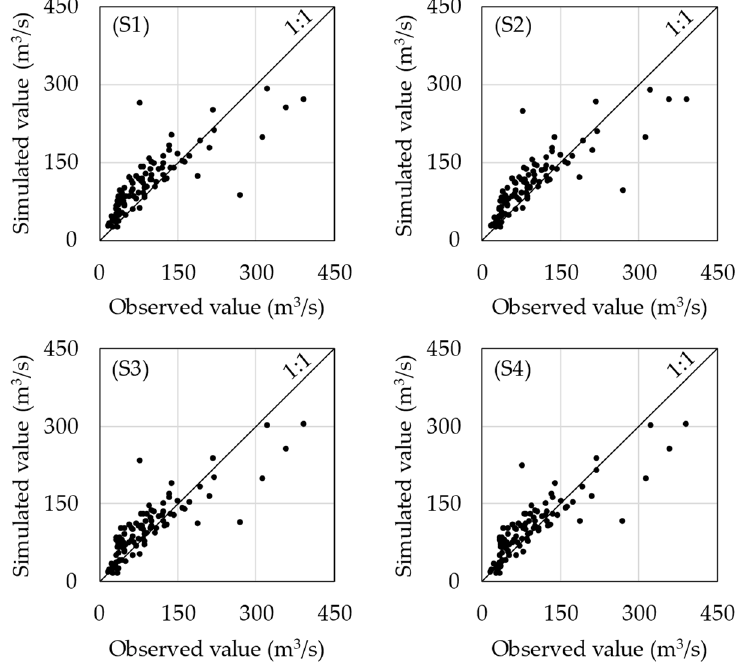
Figure 5. The correlation between the observed and simulated flow discharges in the validation period. S1 represents the simulation results when using the 2005 land- use map for the entire validation period. S2 represents the simulation results when using the 2010 land- use condition for the entire validation period. S3 represents the simulation results when using two land- use condition types for 2010 and 2015, and then linearly interpolating toward 2015 after 2010, where the 2015 land- use condition is employed for the 2015–2018 simulation. S4 represents the simulation results when using three land- use condition types during the validation period and linearly interpolating between two land- use conditions.